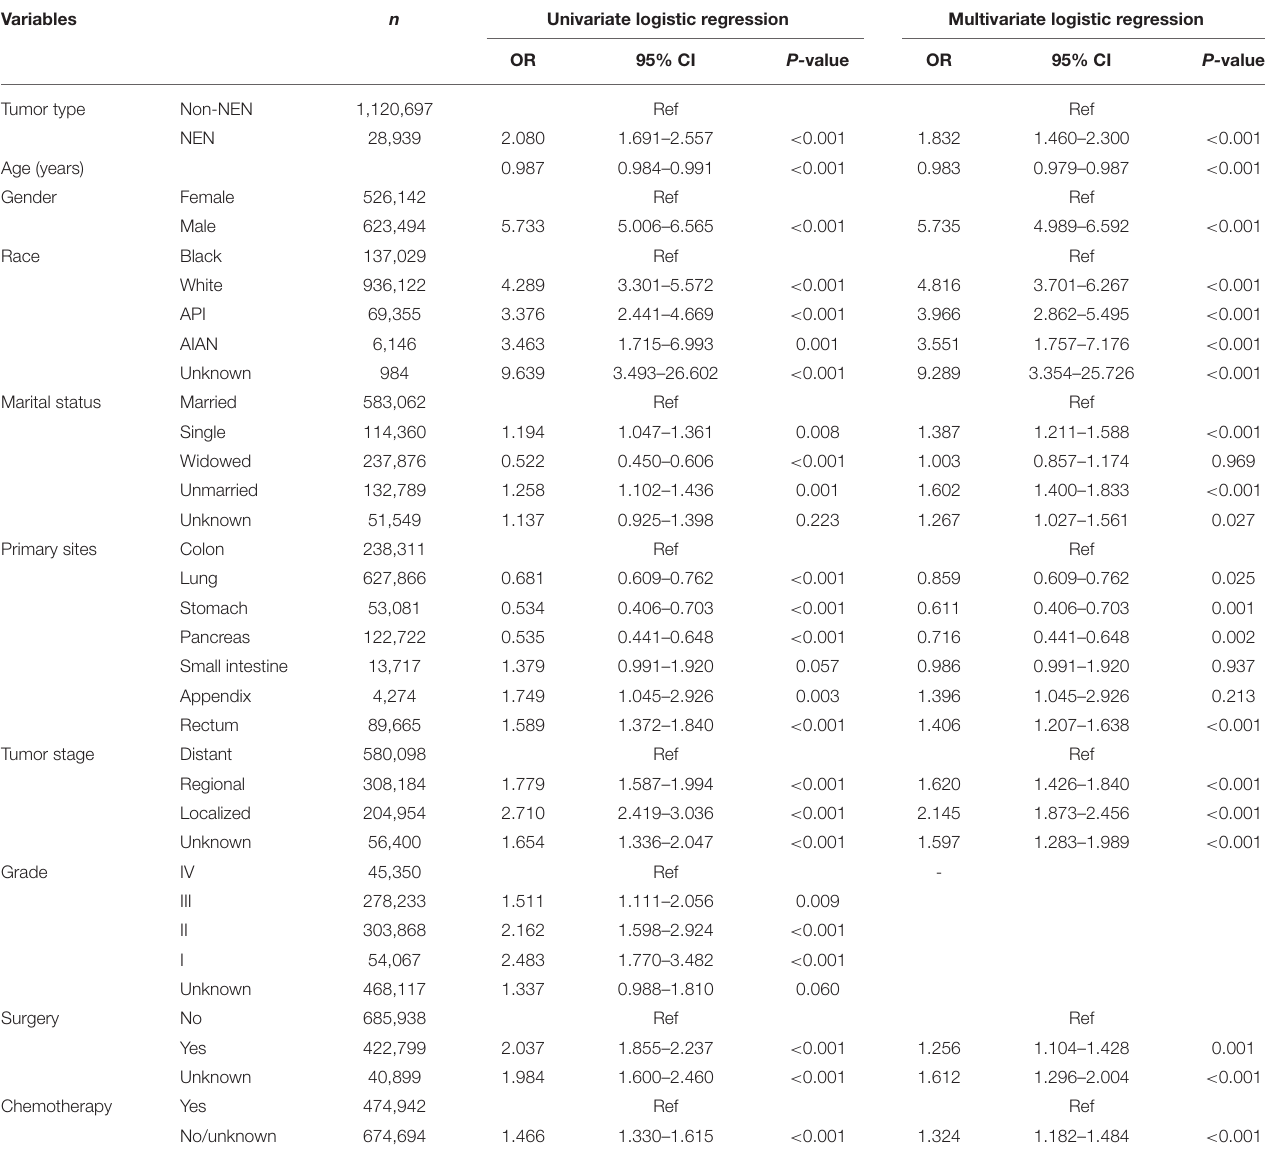
TABLE 1 | Univariate and multivariate logistic regression of suicide in entire cohort. Variables n Univariate logistic regression Multivariate logistic regression OR 95% CI P- value OR 95% CI P-